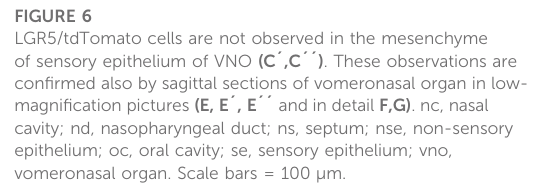
FIGURE 6 LGR5/tdTomato cells are not observed in the mesenchyme of sensory epithelium of VNO (C´,C´´) . These observations are con fi rmed also by sagittal sections of vomeronasal organ in low- magni fi cation pictures (E, E´, E´´ and in detail F,G) . nc, nasal cavity; nd, nasopharyngeal duct; ns, septum; nse, non-sensory epithelium; oc, oral cavity; se, sensory epithelium; vno, vomeronasal organ. Scale bars = 100 μ